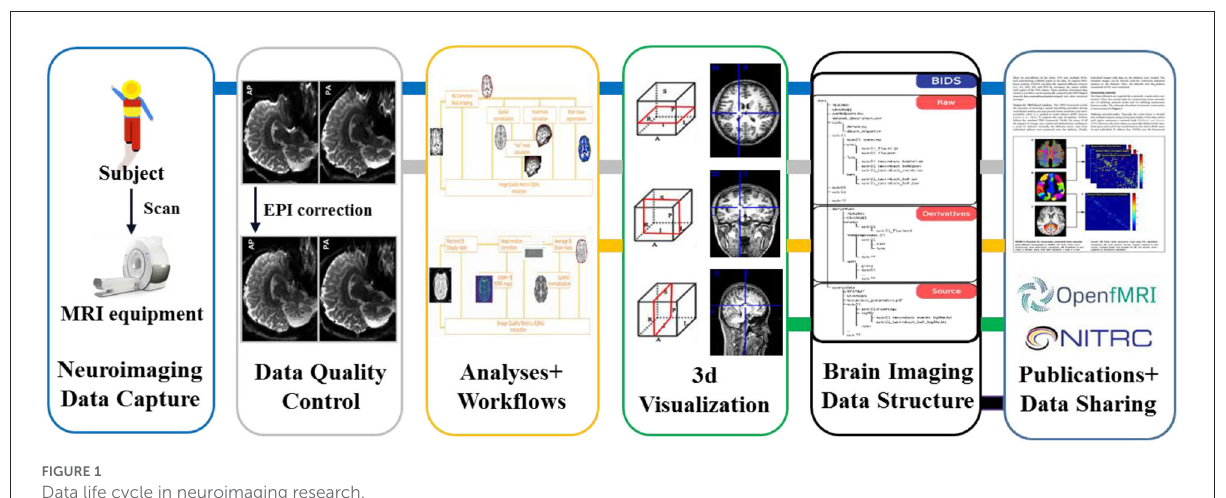
FIGURE1 Data life cycle in neuroimaging